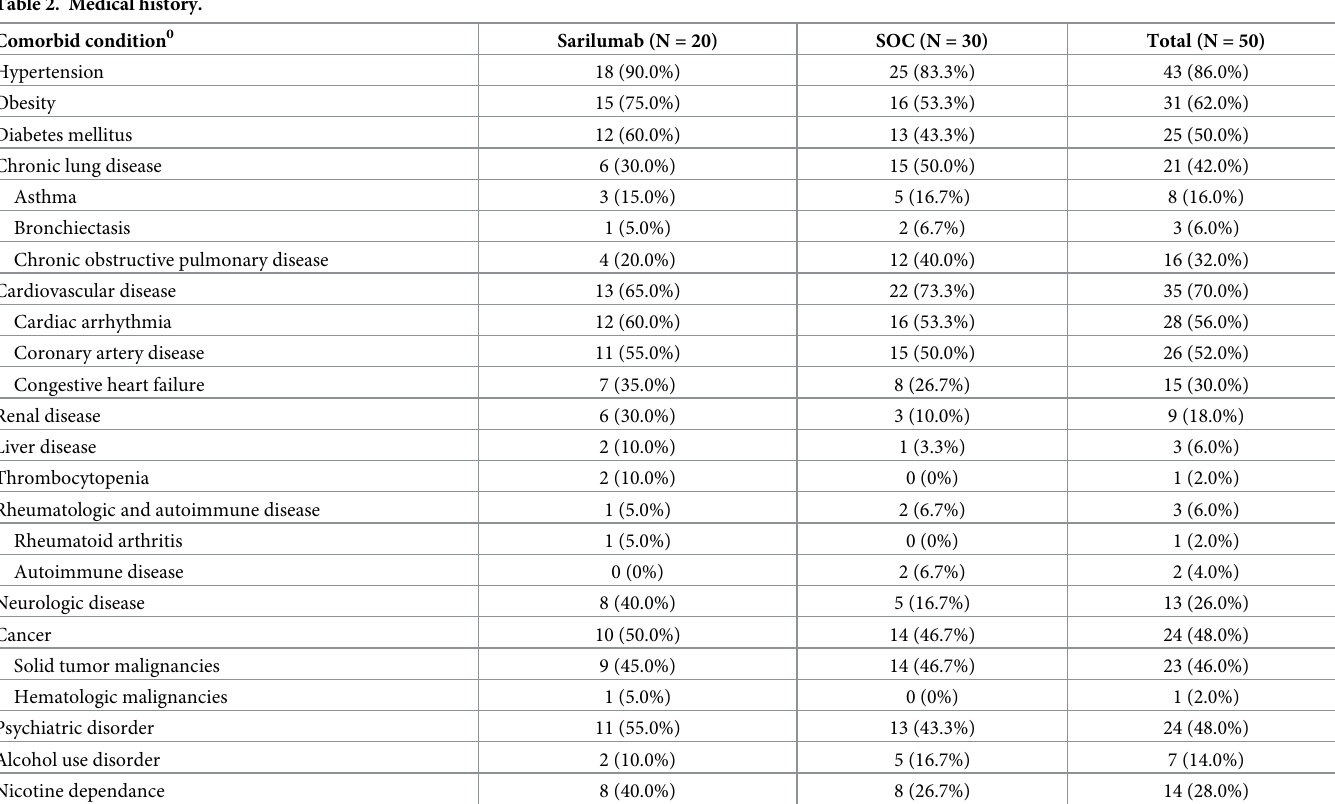
Table 2. Medical history.